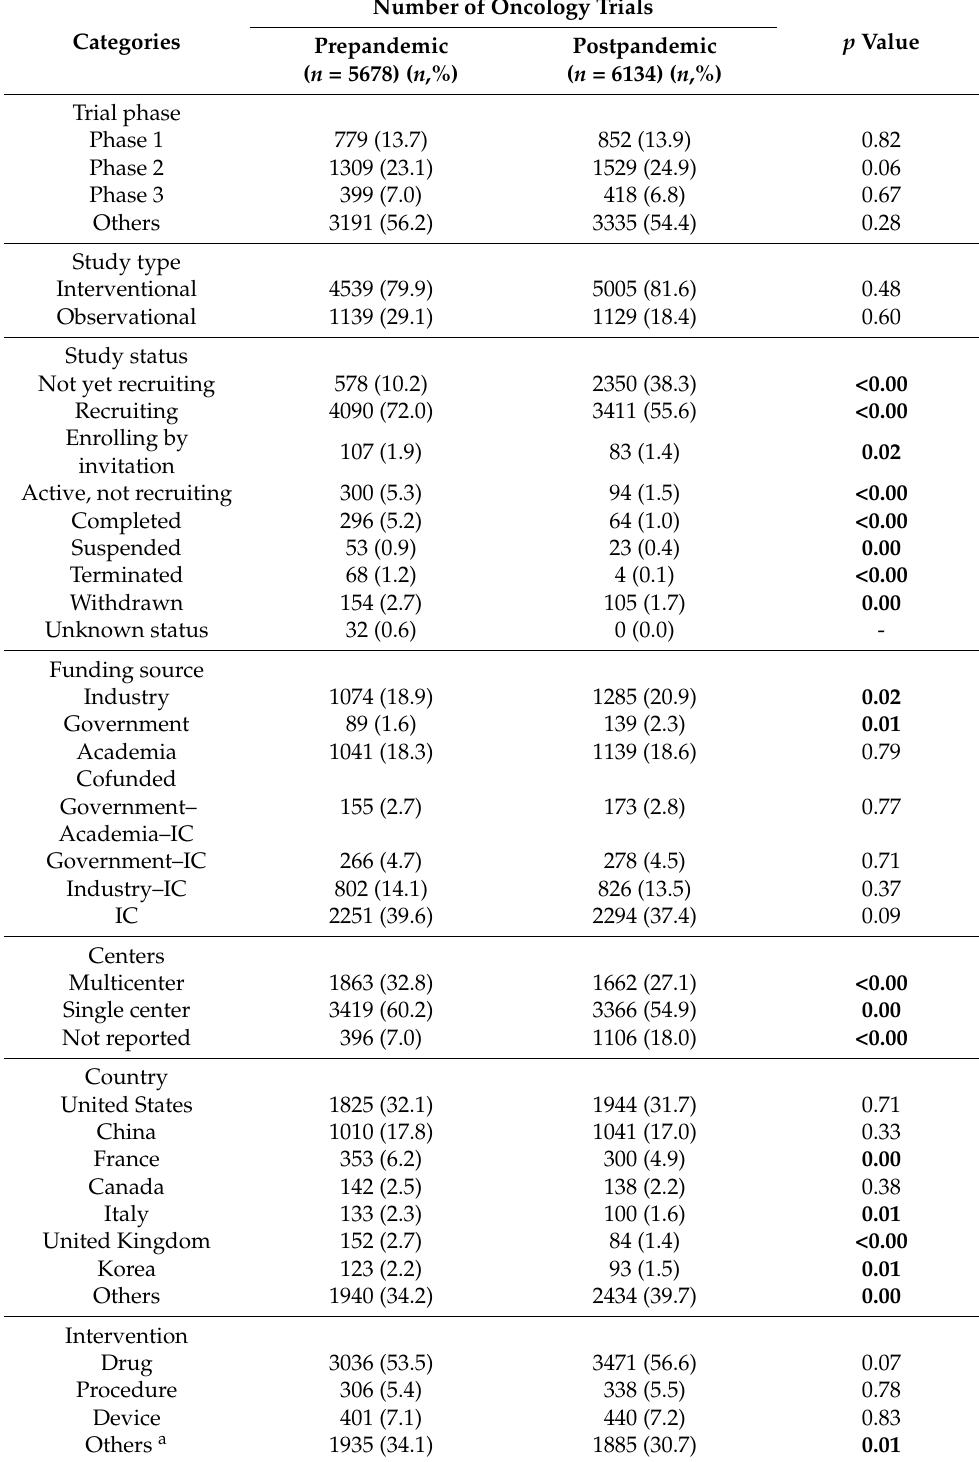
Table 3. Comparison of trends of launching new oncology trials in pre- and postpandemic eras